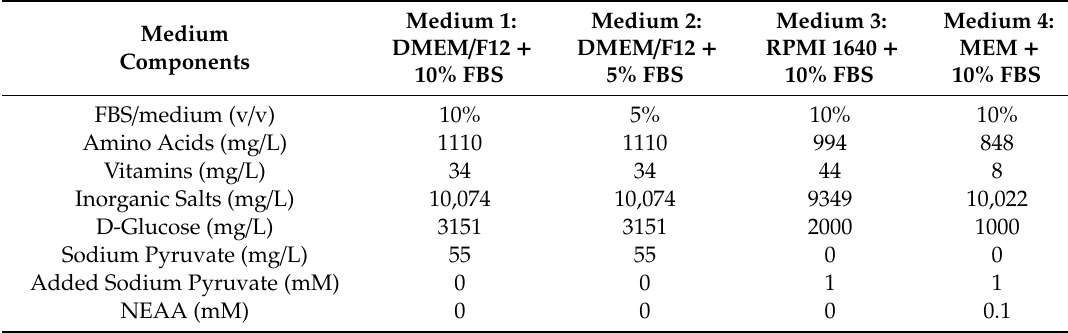
Table 2. Overview of culture media used in the study and their respective components and concentrations. FBS, fetal bovine serum; NEAA, non-essential amino